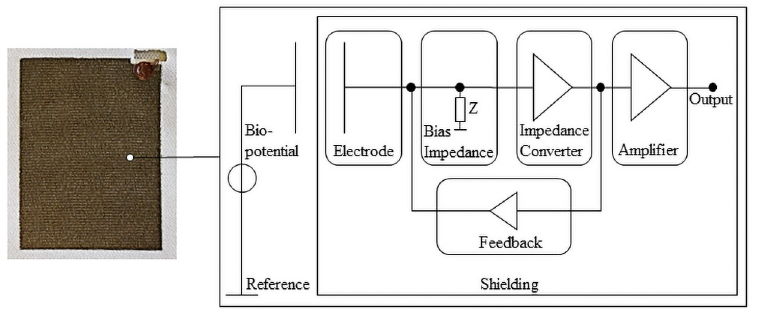
Fig 2. Schematic diagram of textile capacitive electrodes [21].